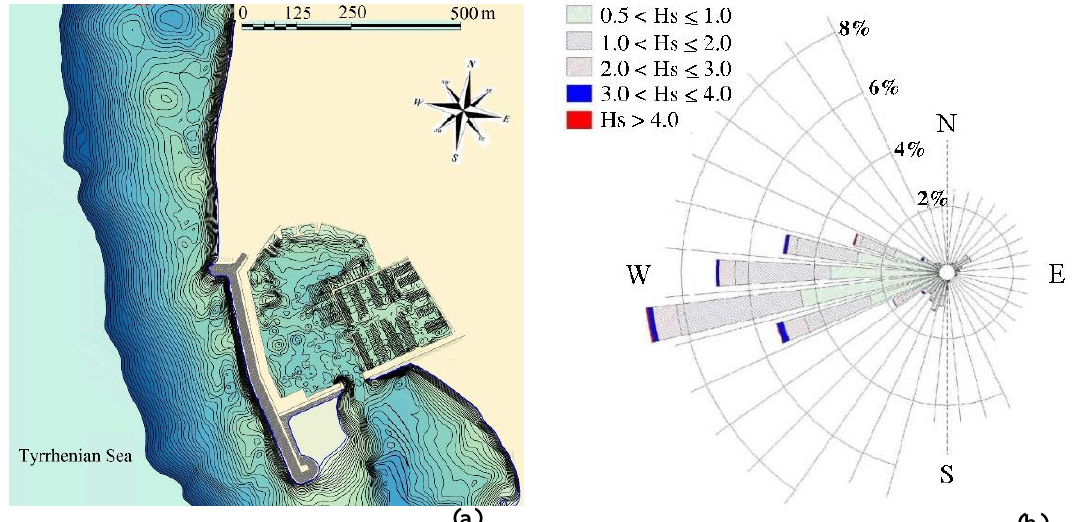
Figure 6. (a): Plan view of Cetraro harbour (Italy). (b) : Wave height directional distribution offshore Cetraro harbour.